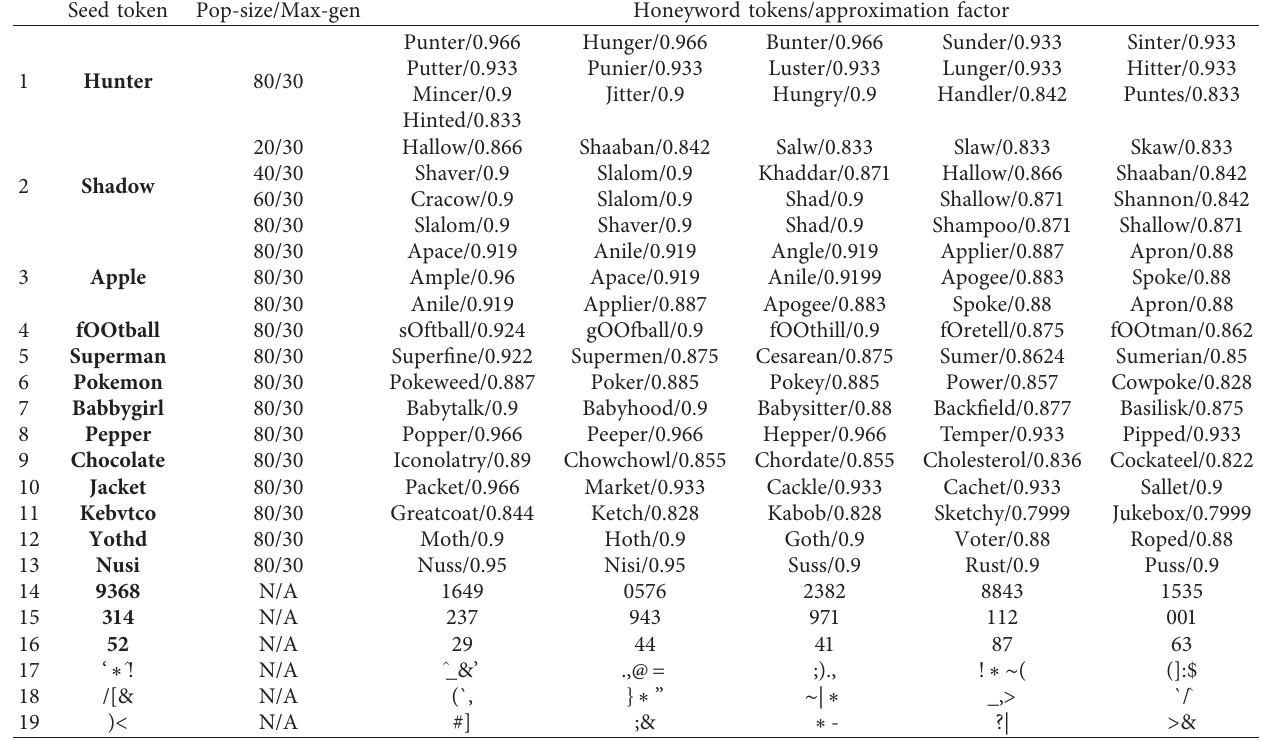
Table 2: Experimental results of the proposed